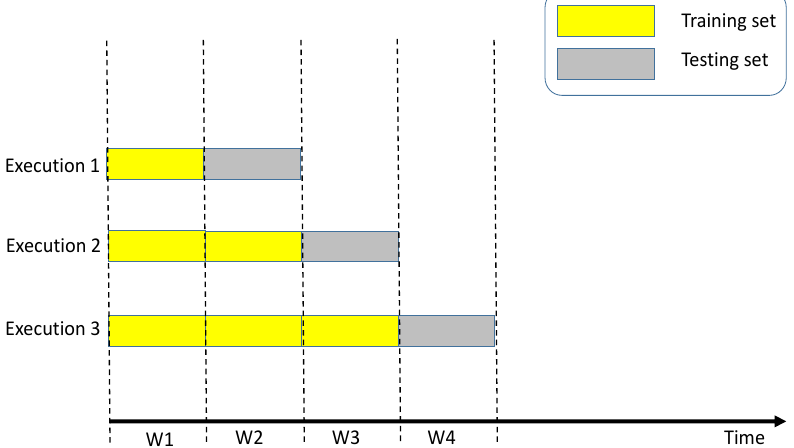
Figure 5. The walk-forward working mechanism for 5 weeks (units).